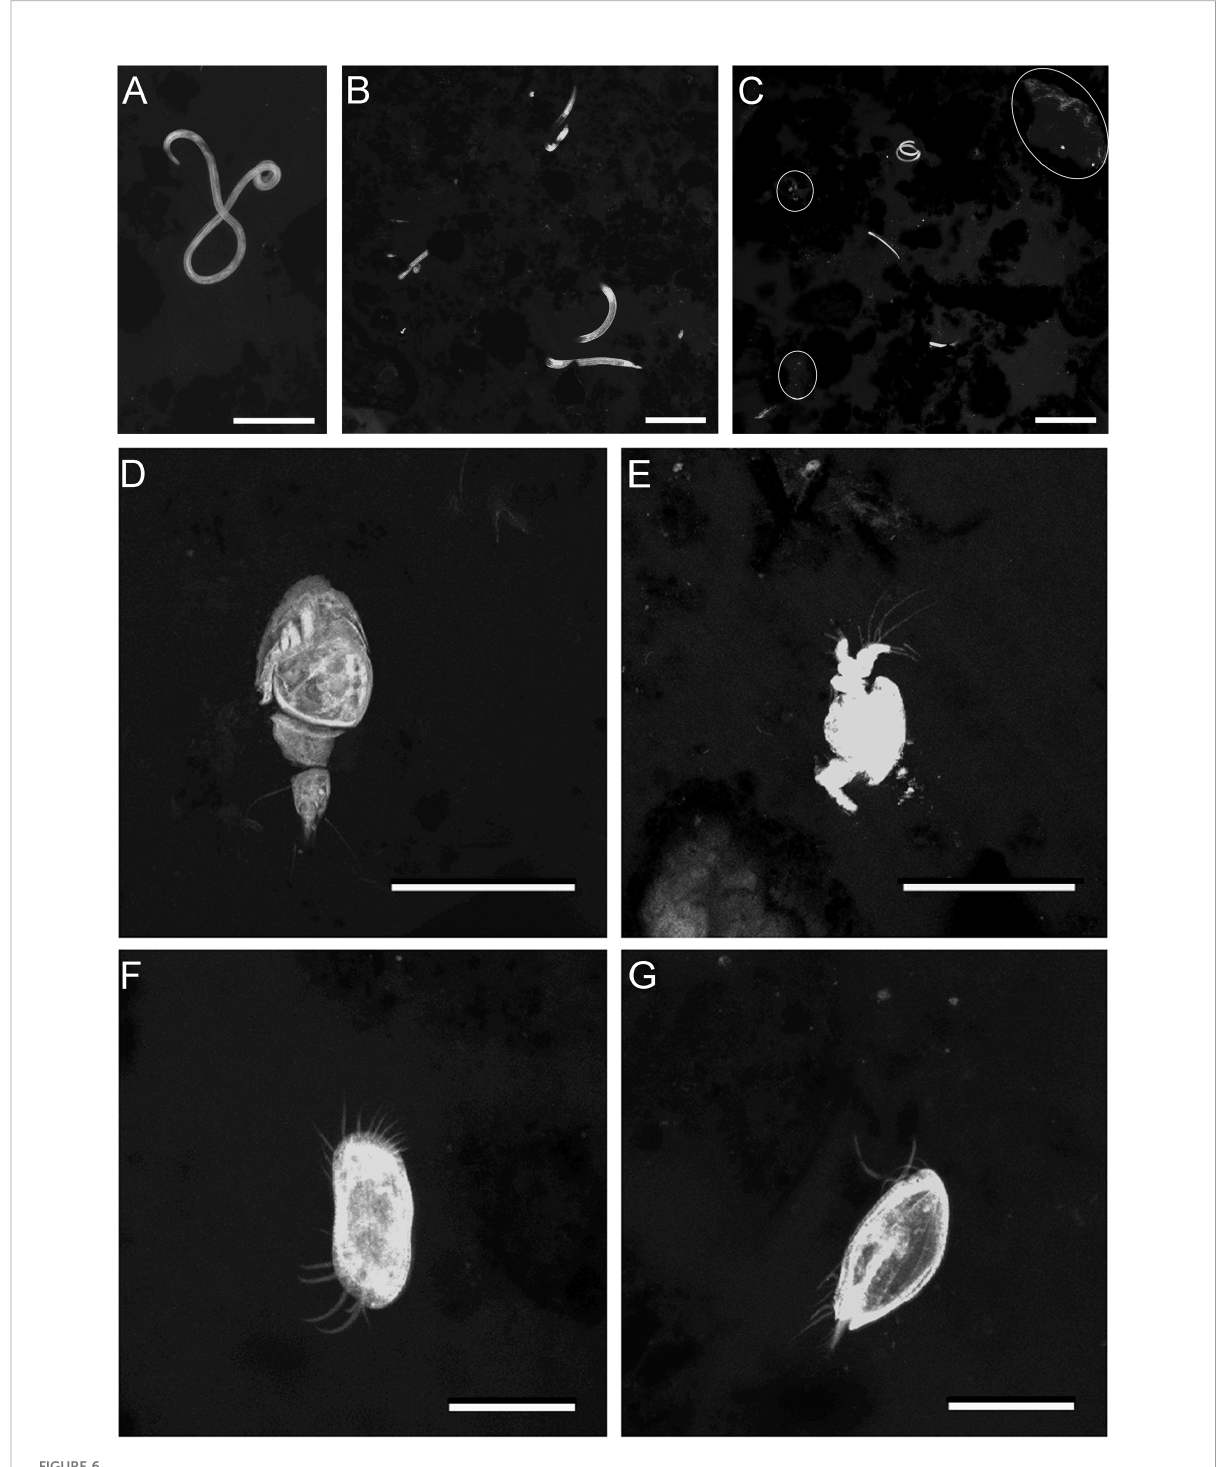
FIGURE 6 FLEC LSCM images (z-stacks) showing metazoan meiofauna from chimney-base sediments. (A – C) Nematodes in Core 8. (A) Single nematode, ~3mm depth. (B) Three nematodes, ~3 mm depth. (C) Three nematodes, ~5 mm depth. White outlines highlight microbial aggregations. (D) Copepod juvenile, Core 7, ~0.5 mm depth. (E) Possible fragment of nauplii, Core 4, 4 mm depth. (F) Ostracod ( Argilloecia sp.)?, Core 19, 3 mm depth. (G) Possible bivalve veliger, Core 19, 1 mm depth. White ovals highlight areas with bio fi lms or aggregated microbes. Number of images compiled/distance between images ( m m): (A) =71/0.7; (B) =29/1.4; (C) = 58/1.4; (D) = 23/0.7; (E) = 24/0.7; (F) = 64/0.5; (G) = 61/0.5. Scales: (A, D, E) = 100 µm; (B, C) = 200 µm; (F, G) = 50